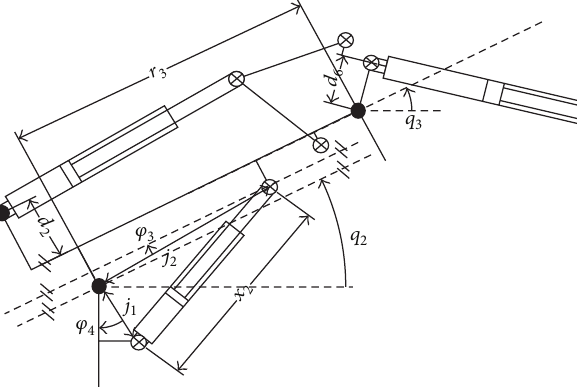
Figure 2: Geometry of the first link joint 𝑞 2 as a function of the cylinder’s displacement 𝑥 2 . The schematics show the portion related to the motion 𝑞 2 from Figure